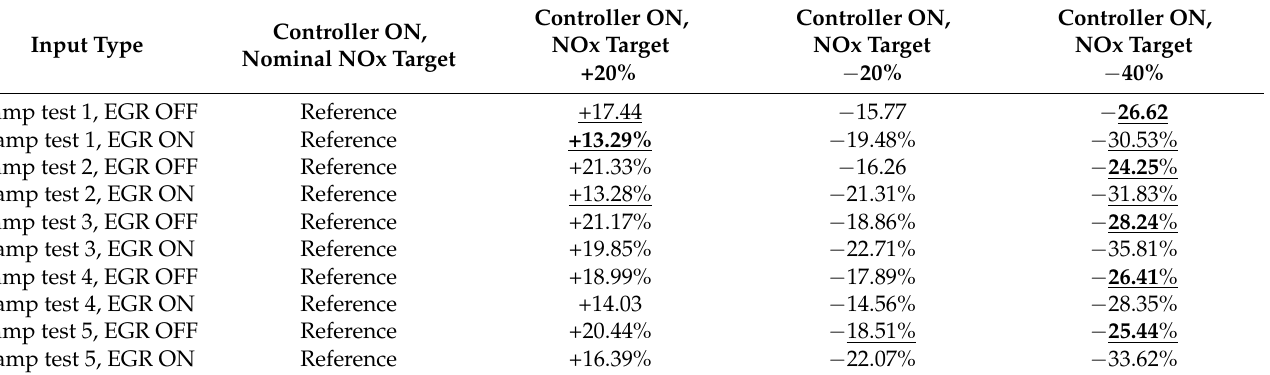
Table 6. Ref [10]. Relative differences in the values of the cumulative NOx index, with respect to the baseline case, in which the controller was activated with the nominal NOx target. The underlined values indicated in bold refer to the test conditions in which the boundaries of SOI main were reached for a significant portion of the test, while the other underlined values indicate the test conditions in which the boundaries of SOI main were reached but for a limited portion of the